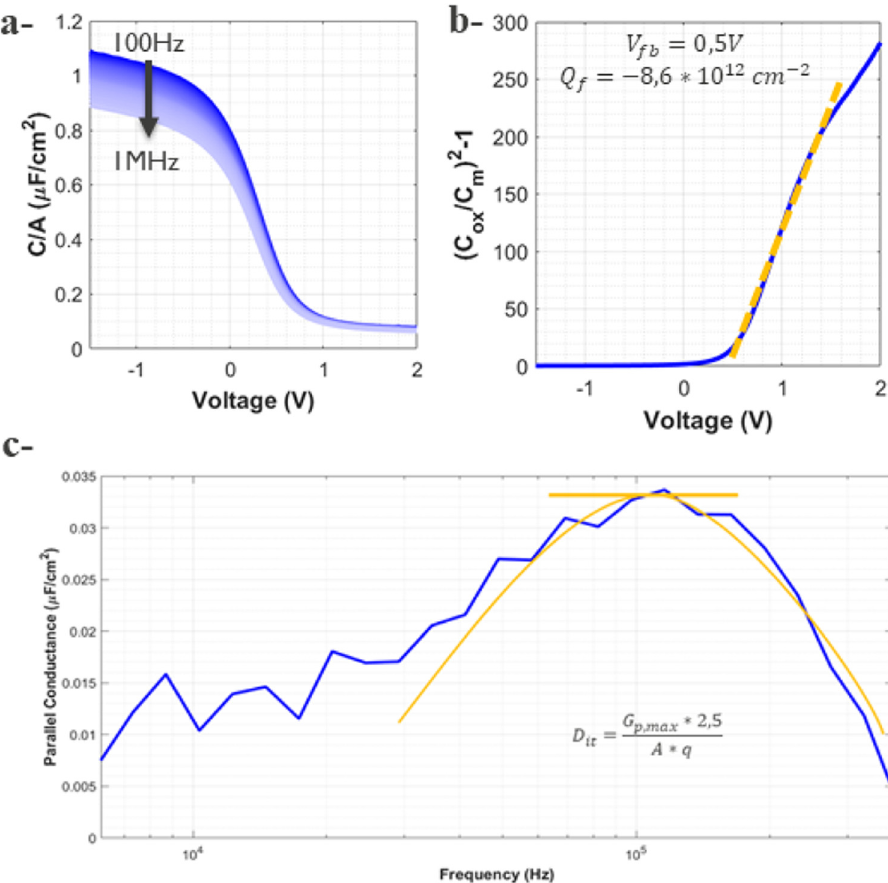
Fig. 3. (a) Capacitance-voltage (C-V) graph, (b) (C ox /C m ) 2 (cid:2) 1 as a function of voltage and (c) parallel conduction as a function of